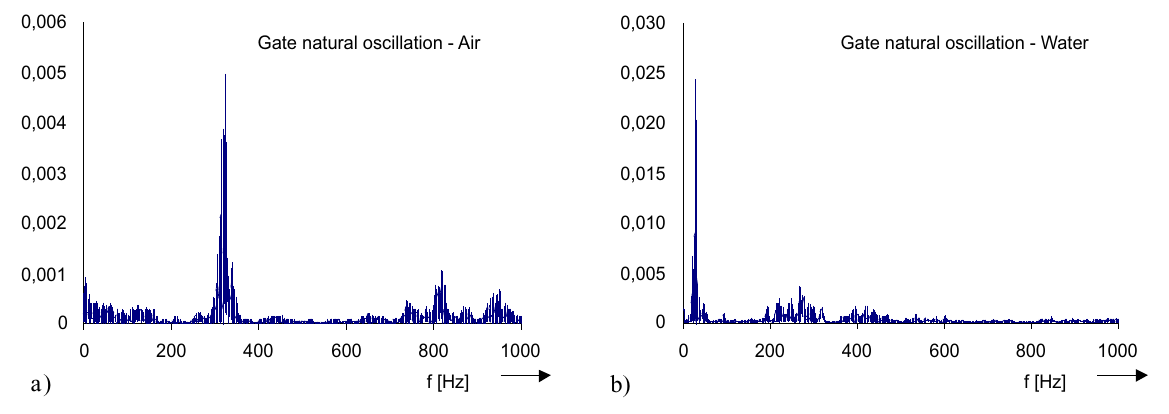
Fig. 4. Power spectra records of the gate natural vibration, determined in air (a) and in water